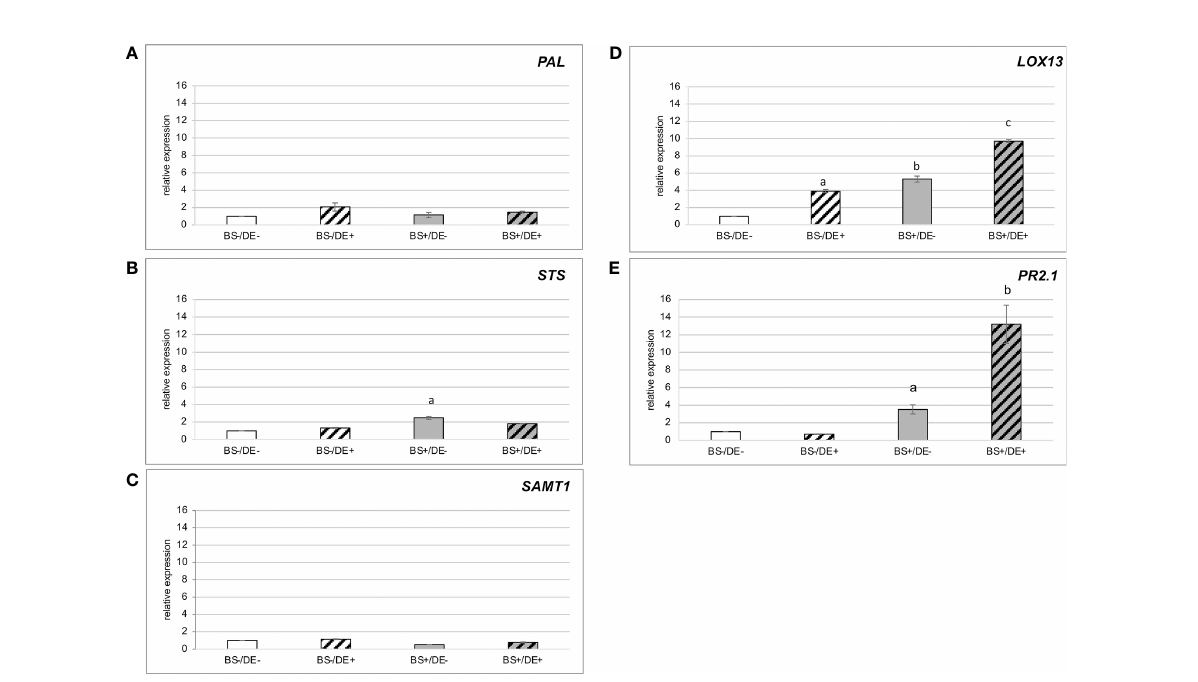
FIGURE 9 Relative expression of defense-related genes in leaves of plantlets treated by BS and/or DE. Grapevine micro-cuttings were transplanted in a solid medium supplemented with BS 0.1% (v/v, “ BS+ ” ) or water ( “ BS- ” , as control). At 4 wpt, they were divided into two sets: one treated by immersion in a defense elicitor solution (DE+) and the other one in water as control (DE-). Two days later, leaves were collected. The expression of fi ve genes encoding a (A) phenylalanine ammonia-lyase 1 (PAL), (B) stilbene synthase (STS), (C) salicylic acid methyltransferase (SAMT1), (D) lipoxygenase 13 (LOX13), (E) b -1.3 glucanase (PR2.1) were investigated by qRT-PCR. Results represent relative fold expression calculated with the 2 - DD CT method and normalized against the two reference genes EF1 a and VATP16 as internal controls for each respective time point. Data represent mean of three technical replicates of one biological repetition. The bars represent the standard deviations and a signi fi cant difference is observed when the treatments have no letter (a or b) in common ( P < 0.05; Kruskall-Wallis